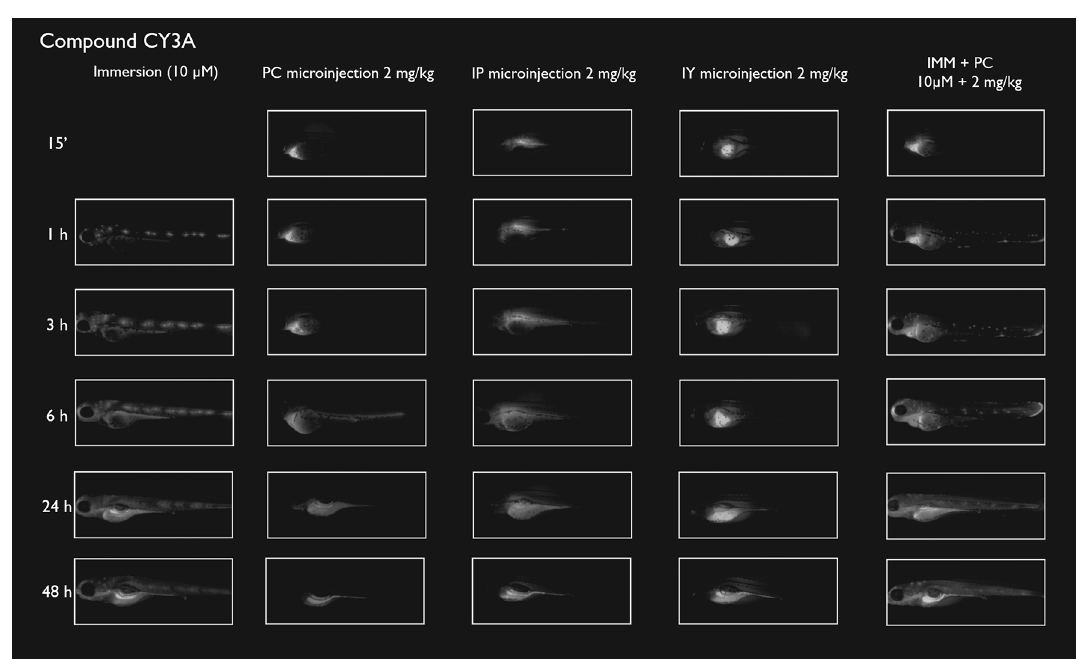
Figure 7. Representative pictures of the spatiotemporal distribution of the fluorescent compound CY3A. The eleuthero-embryos were exposed to the dye by immersion (10 µM) or microinjection (2 mg/kg) in the pericardial cavity (PC), intraperitoneally (IP) and in the yolk sac (IY), or by a combination of immersion and PC microinjection, for 48 h starting from 3 dpf. Staining of neuromast cells of the lateral line is visible 1 h post-immersion. Selected images arranged in MS PowerPoint and GIMP (version 2.10.24 https:// www. gimp. org/ 2021)